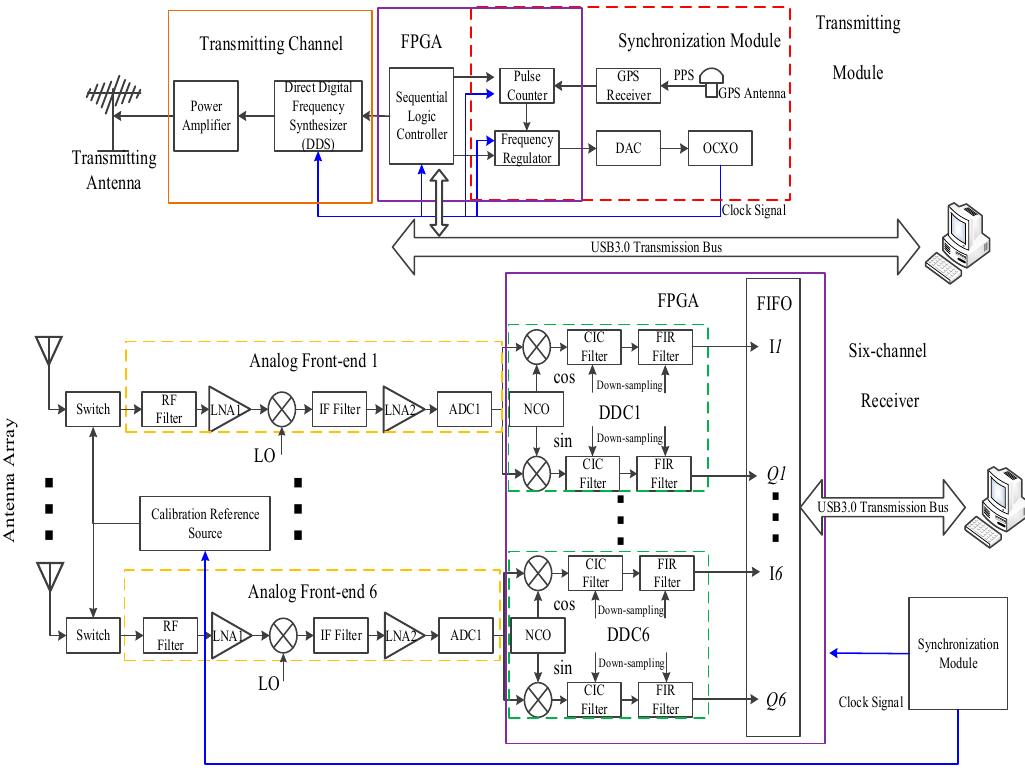
Figure 1. The specific architecture of the system.